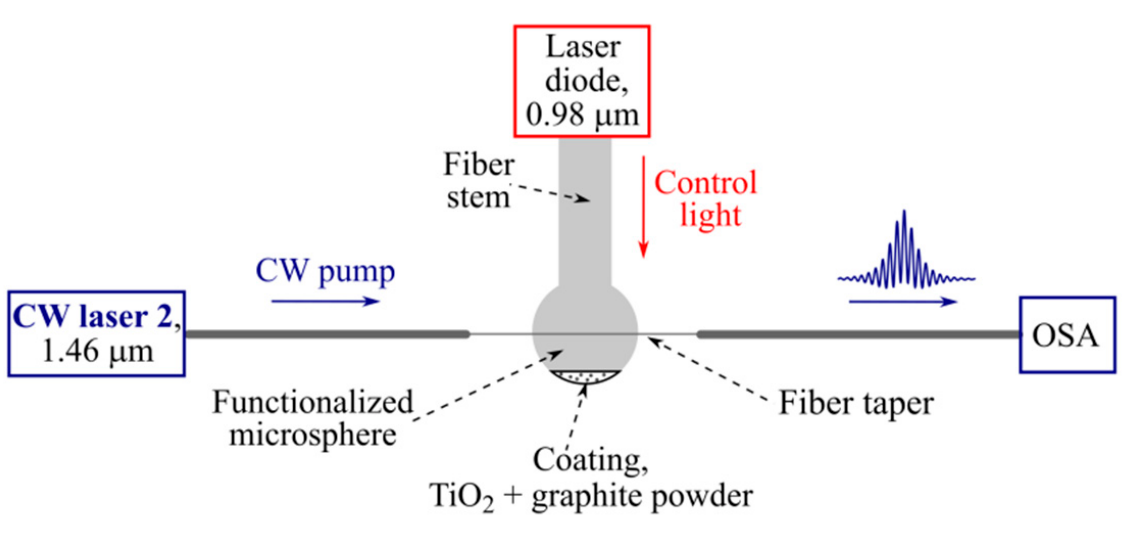
Figure 4. Schematic diagram of experimental setup for Raman soliton generation in functionalized microsphere pumped at 1.46 µm under thermo-optical control by laser diode at 0.98 µm.